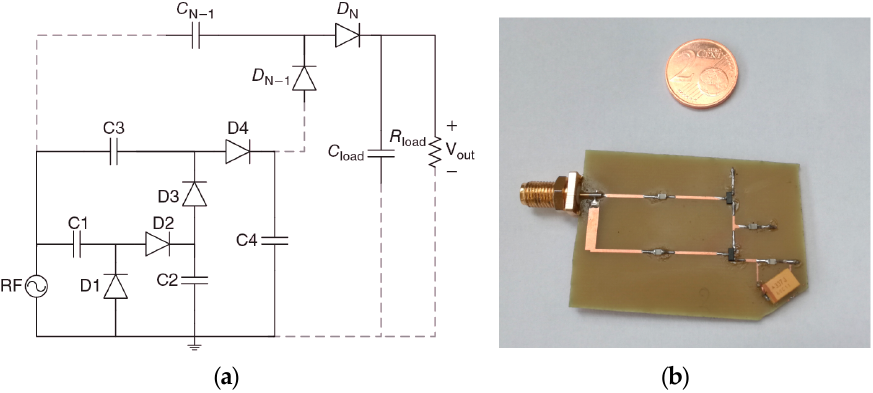
Figure 4. ( a ) Basic topology of the Dickson N-Stage Rectifier [2], ( b ) The proposed rectifier circuit implementation from FR4 PCB board with dielectric constant ε r = 4.35.